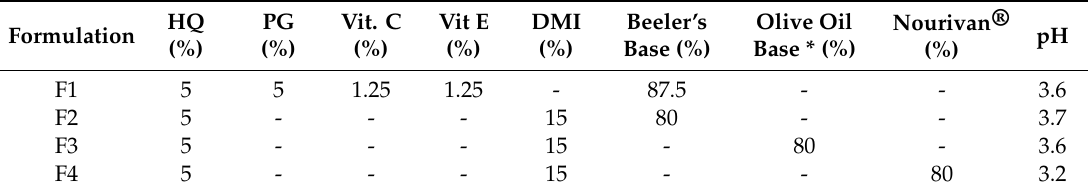
Table 1. Composition of the four developed hydroquinone (HQ) formulations expressed in weight percentage. Key: DMI: Isosorbide dimethyl ether, PG: Propylene glycol, Vit. C: Vitamin C, Vit. E: Vitamin E. Further details in Tables S1 and